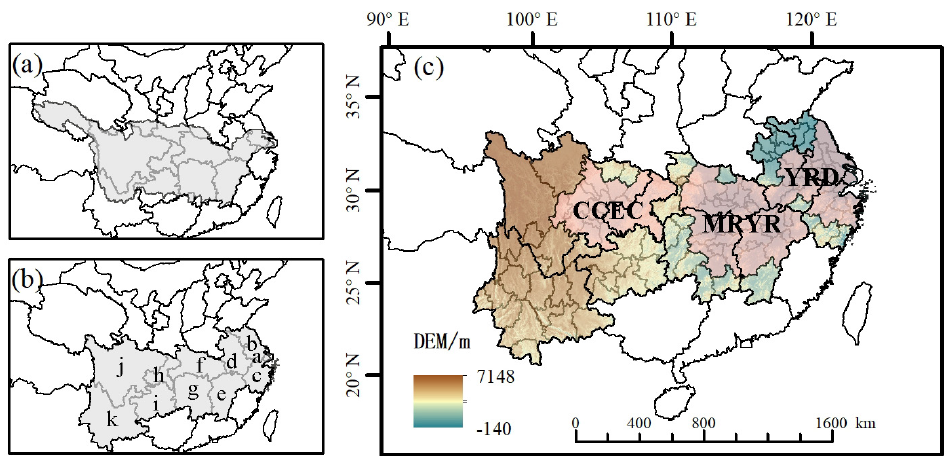
Figure 1. Location of the study area ( a ) the location of the Yangtze River basin; ( b ) the location of the YREB; ( c ): the elevation of the YREB). In Figure 1b, downstream: a. Shanghai, b. Jiangsu; c. Zhejiang; d. Anhui; midstream: e. Jiangxi, f. Hubei, g. Hunan; upstream: h. Chongqing, i. Guizhou, j. Sichuan, k. Yunnan.